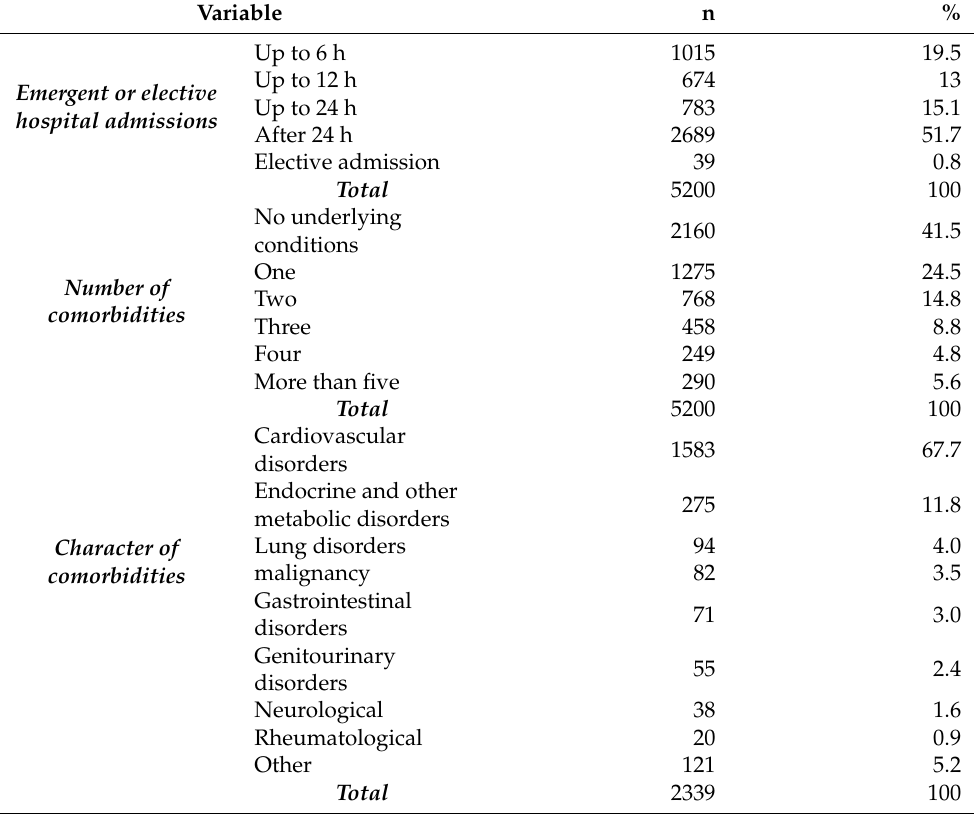
Table 1. Medical characteristics of the patients upon their admission to the hospital.